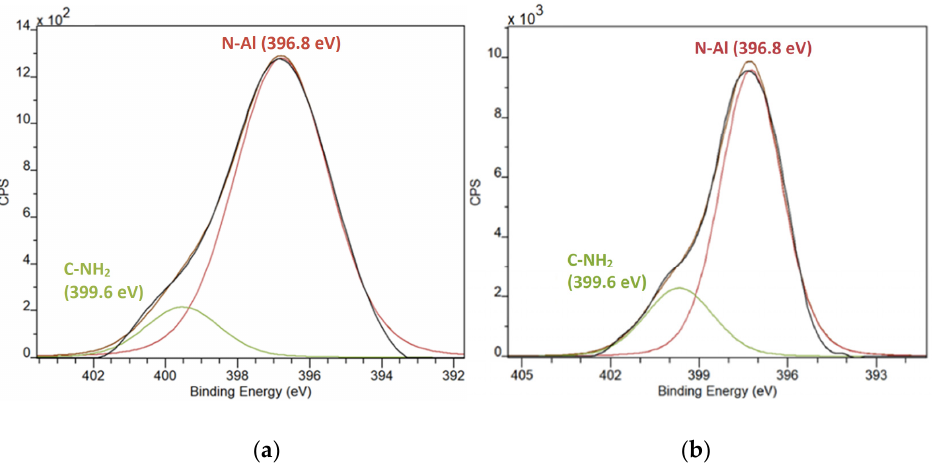
Figure 7. Comparison of high resolution N1s spectra of: ( a ) as-deposited AlN sample; ( b ) annealed AlN sample.